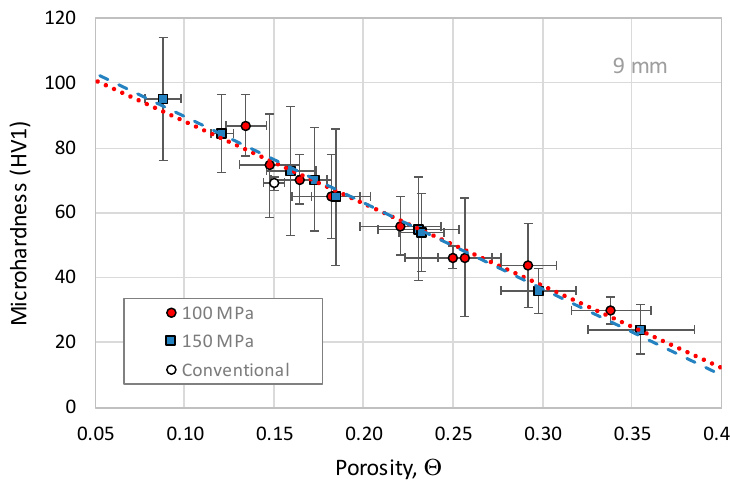
Figure 9. Mean microhardness versus porosity ( Θ ) for 9 mm compacts and the two applied pressures. Lines represent the trend of the two sets of points. The microhardness value of the conventionally consolidated compact is included for comparison.